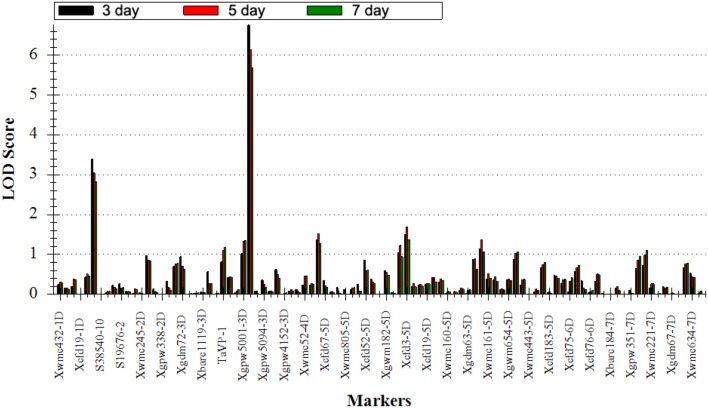
Positions of putative QTLs detected on the day 3, 5, and 7 in the advanced backcross population. Black: LOD of QTLs on the day 3; Red: LOD of QTLs on the day 5; Green: LOD of QTLs on the day 7.